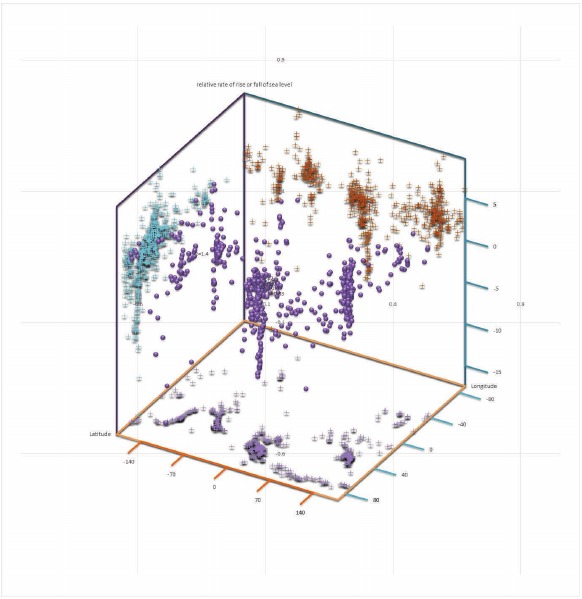
Fig. 2: Relative sea level velocity in the 560 tide gauges of the latest PSMSL survey in mm/year vs. latitude and longitude in degrees. The tide gauges have relative rates of rise ranging from + 9.72 to − 17.42 mm/year with an average of + 1.04 mm/year. These tide gauges have effective record lengths ranging from 183 to 21 years with an average of 56.5 years. The worldwide coverage is poor.